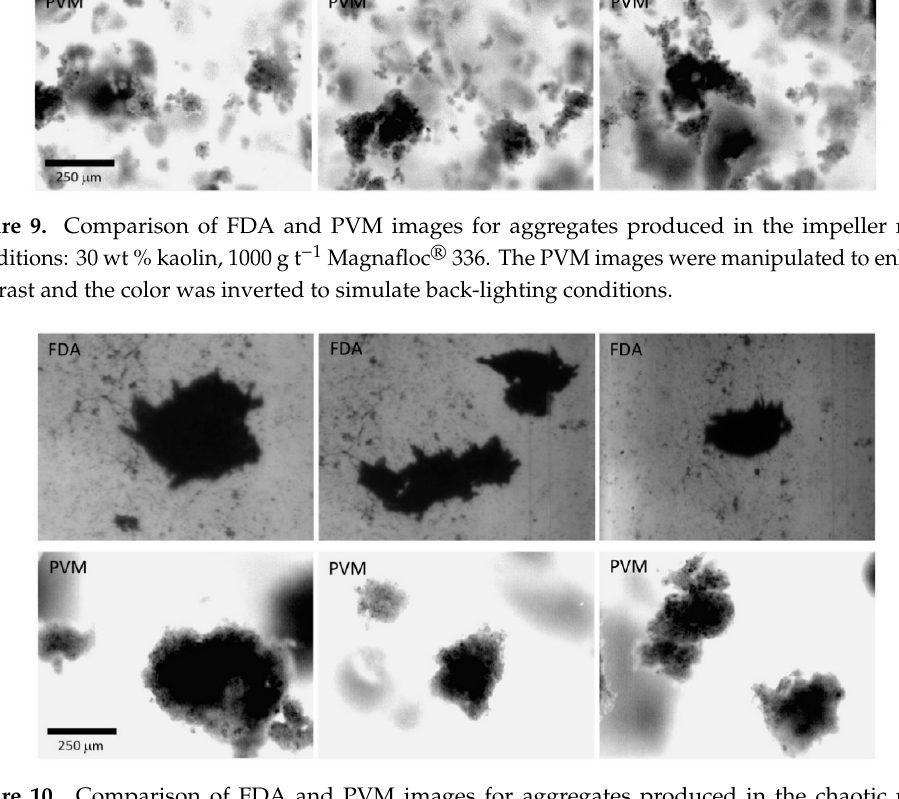
Figure 10. Comparison of FDA and PVM images for aggregates produced in the chaotic mixer. Conditions: 30 wt % kaolin, 1000 g t − 1 Magnafloc ® 336. The PVM images were manipulated to enhance contrast and the color was inverted to simulate back-lighting conditions.